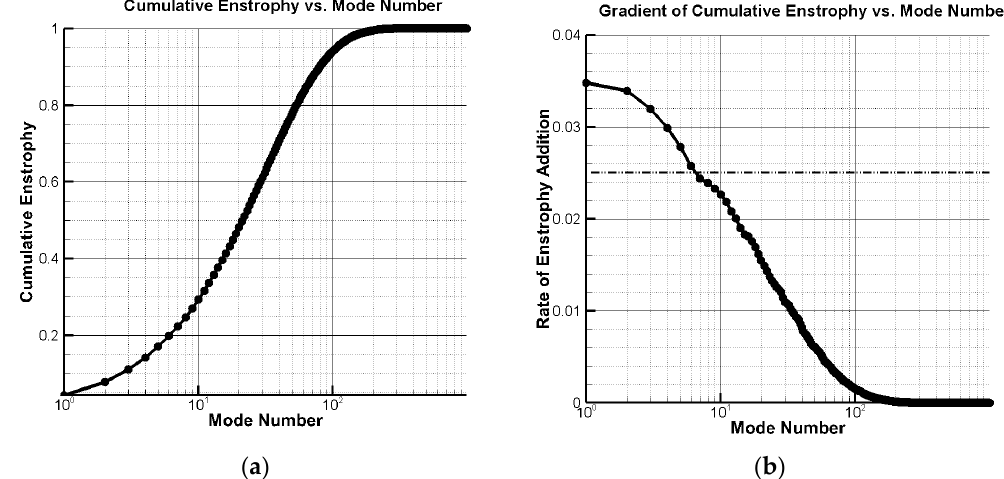
Figure 16. Modal enstrophy content for R2 region. ( a ) Cumulative enstrophy. ( b ) Gradient of cumulative enstrophy.